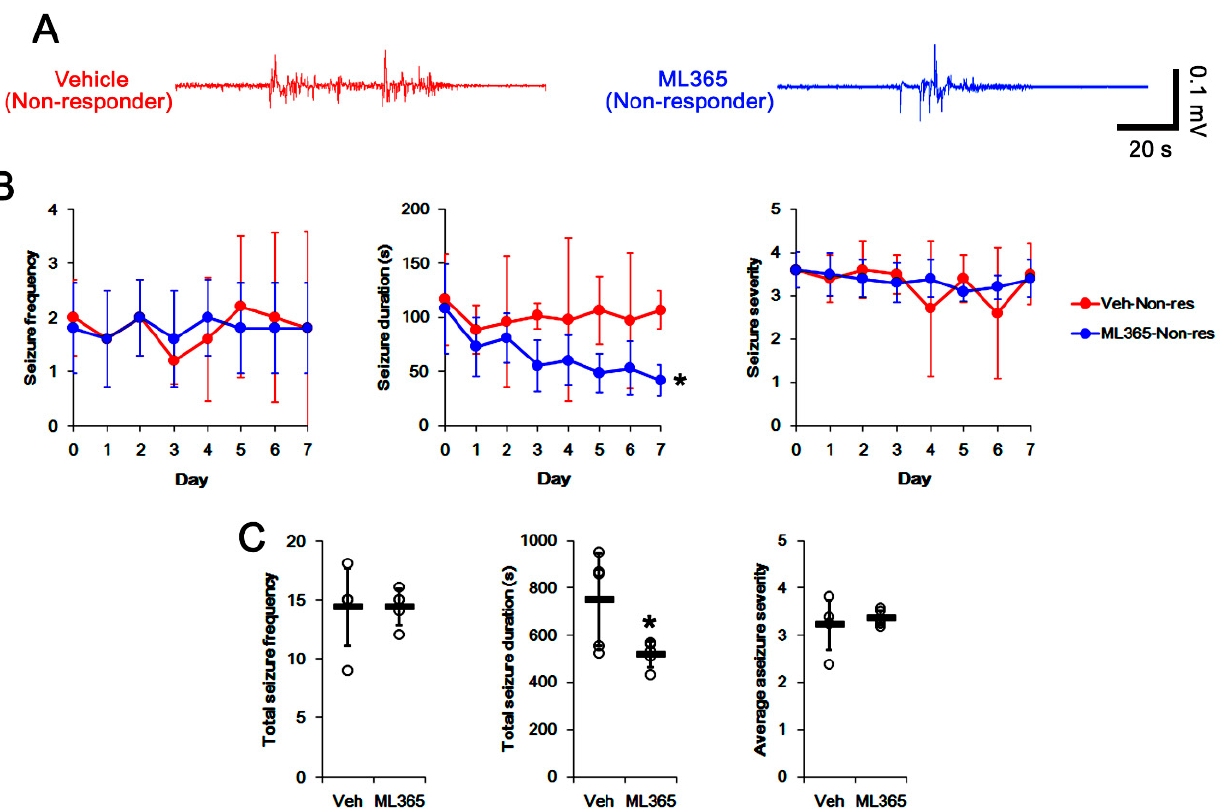
comparison; error bars, SEM). ( D , E ) Representative images for Western blot of TASK-1 protein expression in the hippocampal tissues and quantifications of TASK-1 level based on Western blot results (*,#, p < 0.05 vs. control and vehicle (Veh)-treated animals, respectively; one-way ANOVA with post hoc Bonferroni’s multiple comparison).